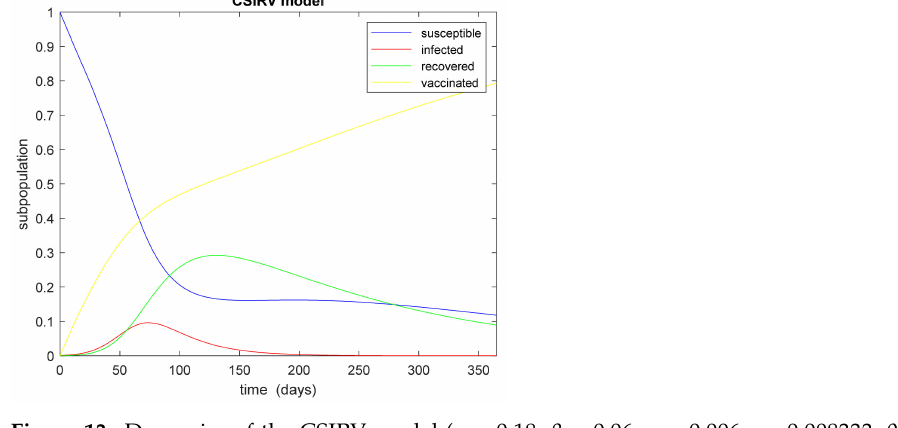
Figure 13. Dynamics of the CSIRV model ( α = 0.18, β = 0.06, γ = 0.006 ε = 0.008333, θ = 0.0006, κ = 0.00008333). Cumulative Viral load = 7.56 (for t = 365 days).